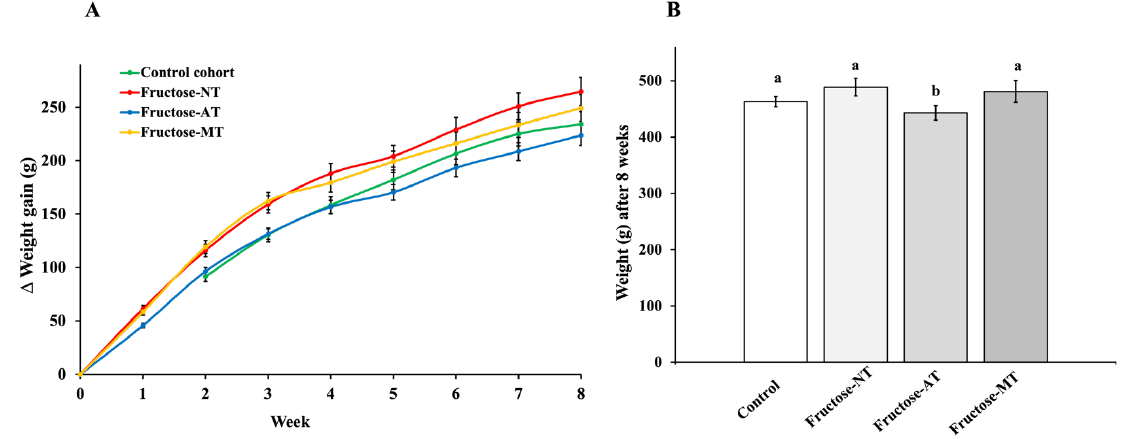
Figure 1. Weight of animals during the experimentation. ( A ) Time course showing the weight gain of animals during the 8 weeks. ( B ) Bar graph showing the weight of animals at the end of the experiment. Different letters show a significant difference at ( p < 0.05).